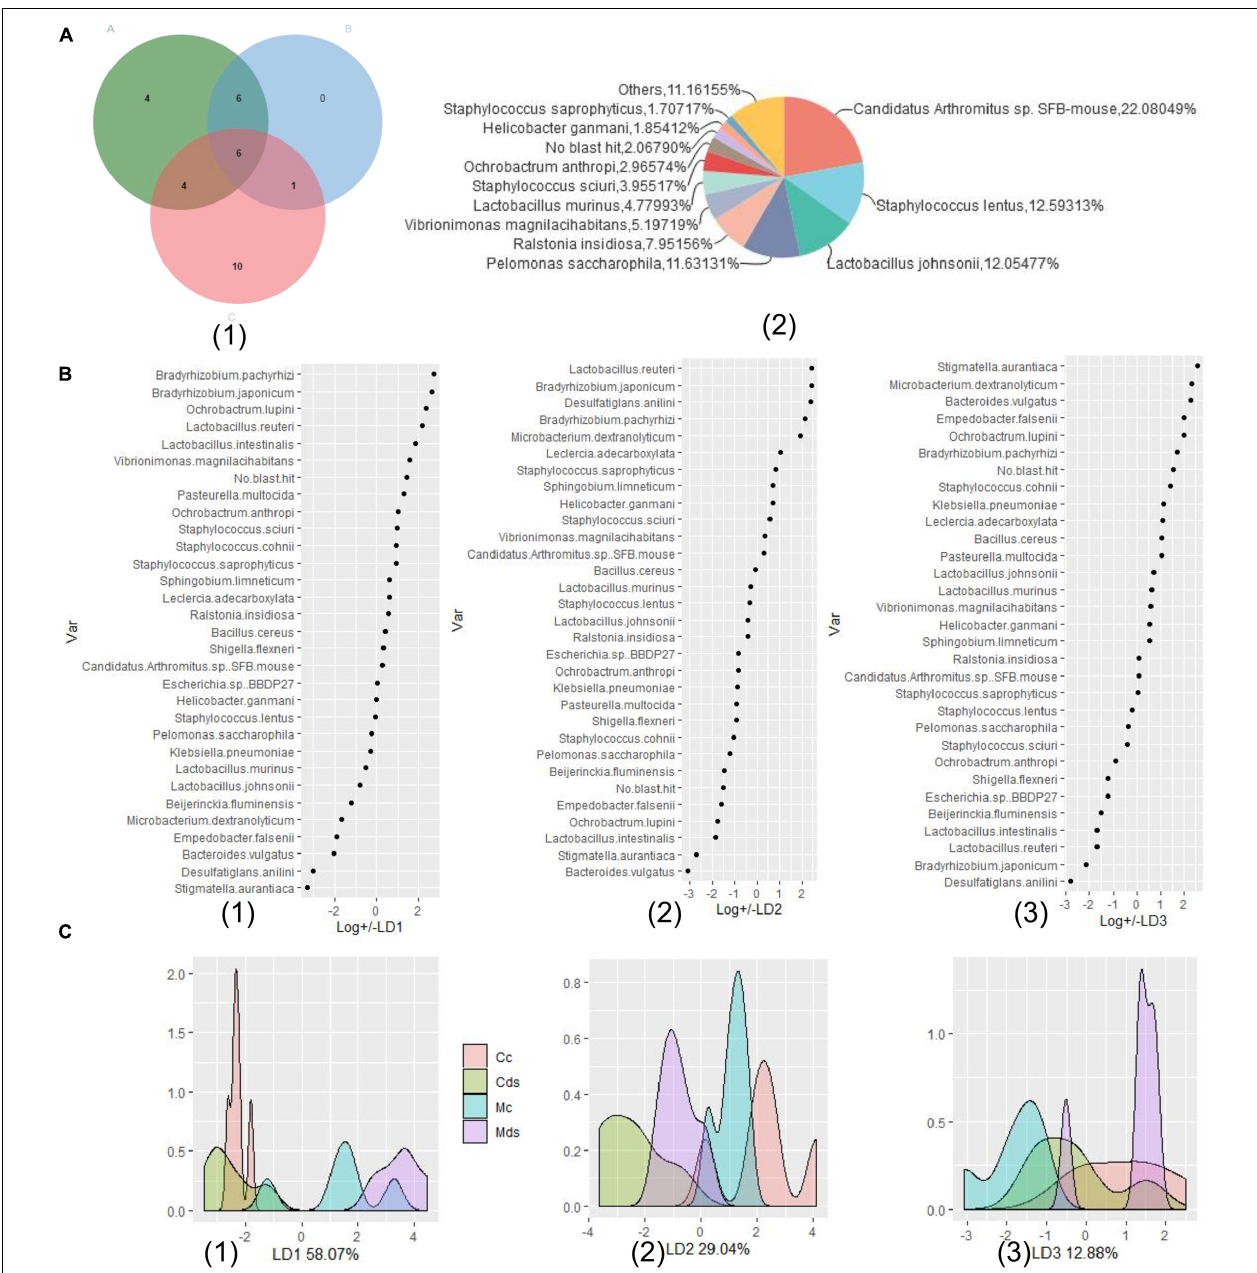
FIGURE 6 | Relative abundance of microbiota-based machine-learning model based on LDA (linear discriminant analysis). (A) Identification of the signature gut microbiota, associated with repeated stress-related diarrhea. (1) To detect signature bacterial markers in response to the repeated stress-related diarrhea, we performed comparison of differences between groups (in green A), LEfSe analysis (in blue B), and relative abundance analysis (in red C) to identify the 31 key bacterial species in response to repeated stress-related diarrhea in the discovery phase. (2) The proportion of relative abundance of the 31 key bacterial species. (B) The relevance of each bacteria in the predictive model was assessed using learning LDA machine-learning classifier in the relative abundance of the 31 key bacterial species, and there are three LDA models, LD1 (1), LD2 (2), and LD3 (3), which can make good classification according to the relative abundance of bacteria. (C) A mathematical model based on the 31 key bacterial species was used to predict the sampling group. (1) Density distribution of samples on the LD1 model (58.07%); (2) density distribution of samples on the LD2 model (29.04%); (3) density distribution of samples on the LD3 model